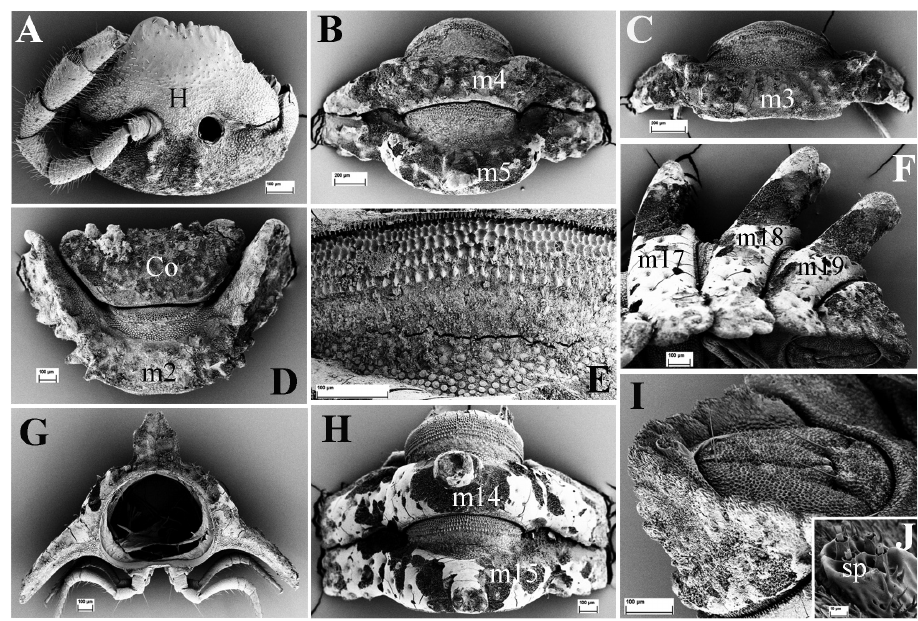
Figure 5. E. deporatus sp. n., SEM, male paratype from Cave Tham Pathok. A head (H) and left an- tenna, frontal view B segments 4 and 5, dorsal view C segment 3, dorsal view (m3–m5 = metaterga 3–5 D collum (Co) and segment 2 (m2 = metatergum 2), dorsal view E prozonum 15, dorsal view F segments 17–19 and telson, lateral view (m17–m19 = metaterga 17–19) G cross-section of segment 6, caudal view H segments 14 and 15, dorsal view (m14–m15 = metaterga 14–15) I telson, subventral view J spinnerets (sp), subventral